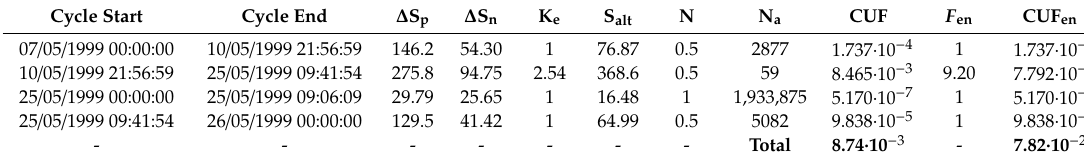
Table A2. Calculations performed to derive the cumulative usage factor (CUF) and the cumulative usage factor considering the environmental e ff ects (CUF en ) in the first sequence of design transients. ∆ S ∆ S + secondary stress range in the pair; K p : total stress range in the pair; n : primary e : elastic-plastic penalty factor; S alt : alternative stress; N: number of cycles; N a : maximum number of allowable cycles.